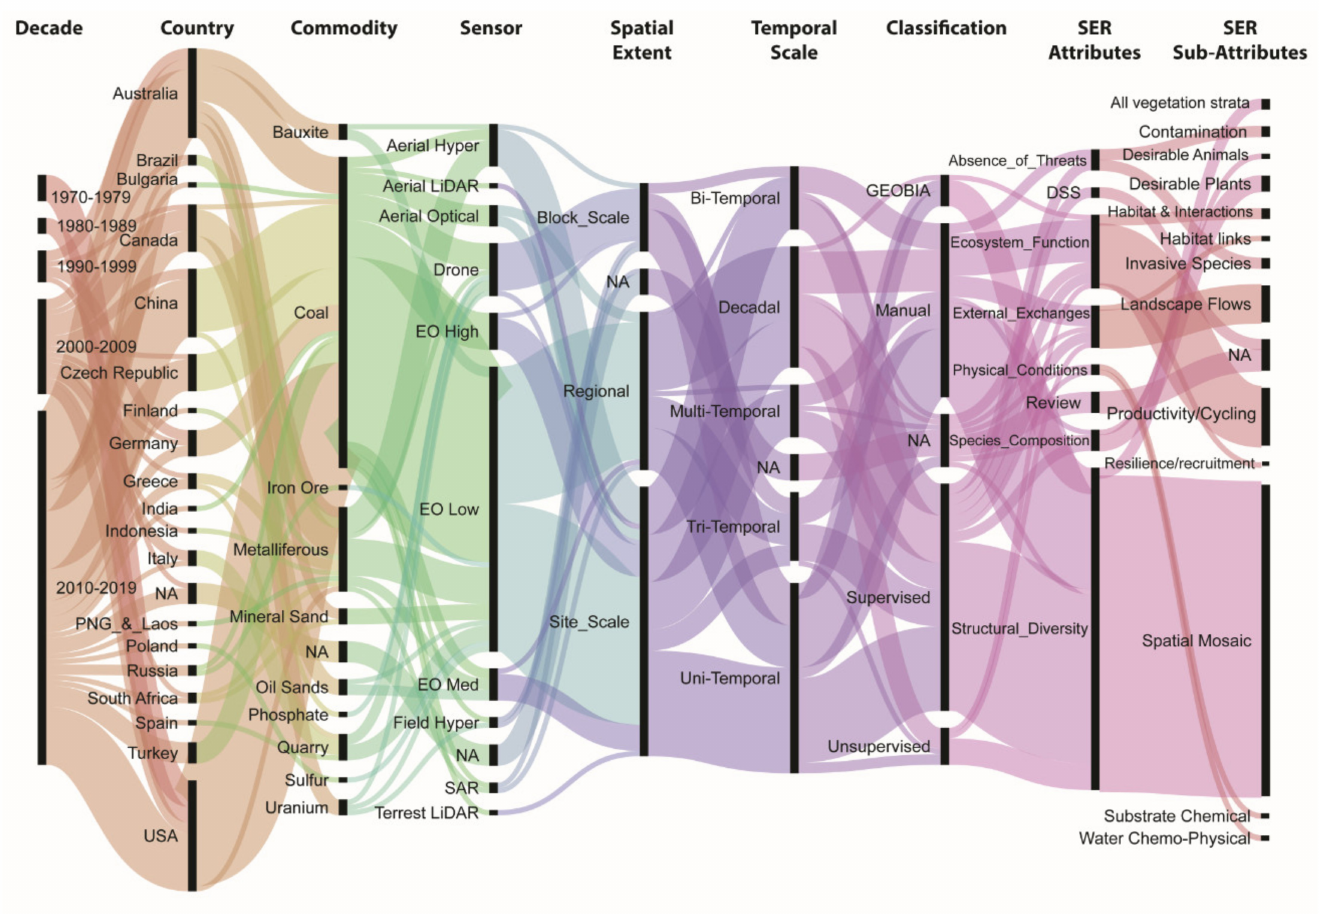
Figure 5. Alluvial chart demonstrating the proportions within variables and the correlations between variables. From Left to Right: Decade of publication, Country of study, Commodity, Sensor used in study, Spatial Extent, Temporal Scale, Classification method, ecological attribute, and ecological sub-attribute. NA = review papers, DSS, and theoretical